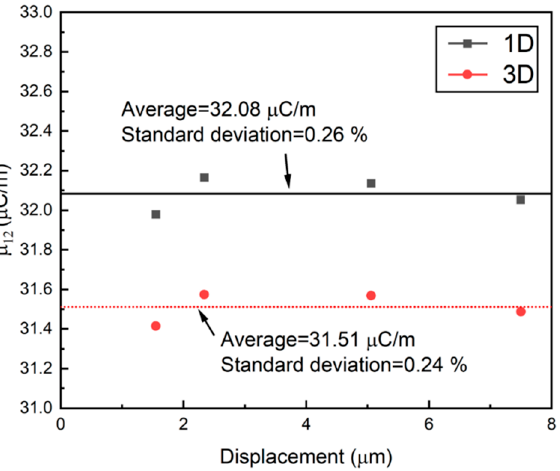
Figure 7. Comparison of flexoelectric coefficients between both approaching cases of 1-D and 3-D stress fields. Table 2. Experimental results of the flexoelectric charge output for various input displacements.